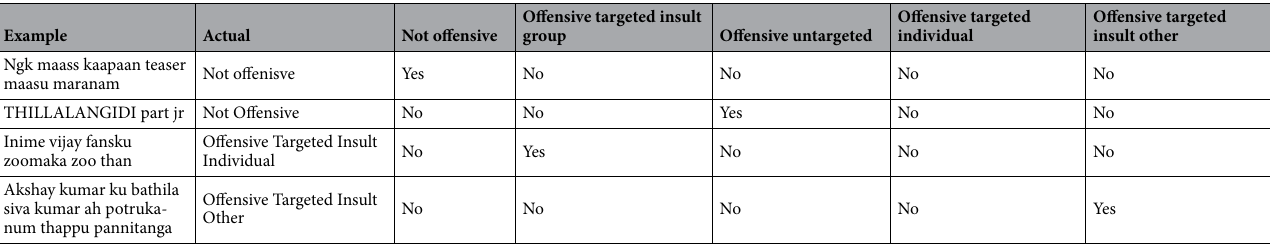
Table 7. Error analysis of samples—offensive language